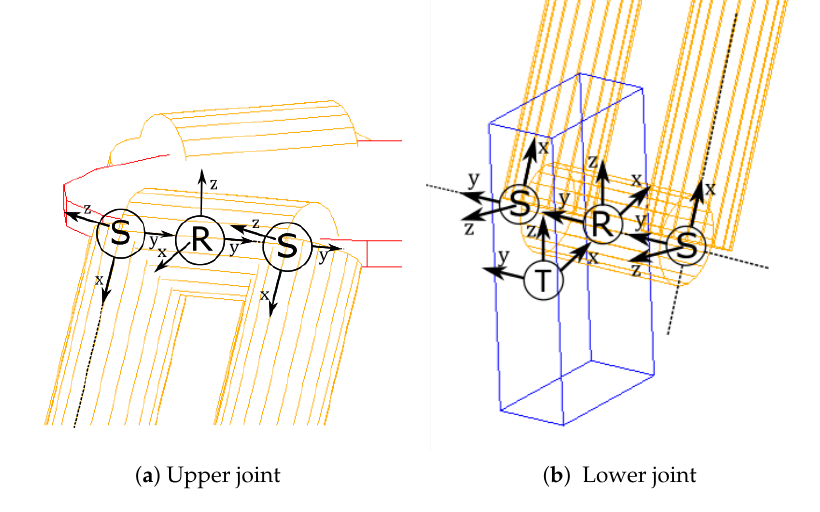
Figure 7. Dynamic Model.